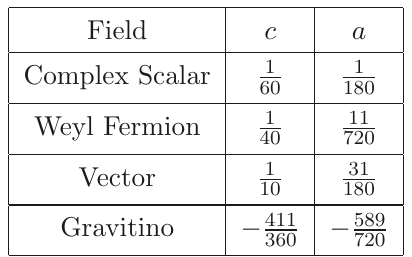
Table 1 . Central charges c and a for neutral fields with minimal coupling to gravity. Each entry has two physical degrees of